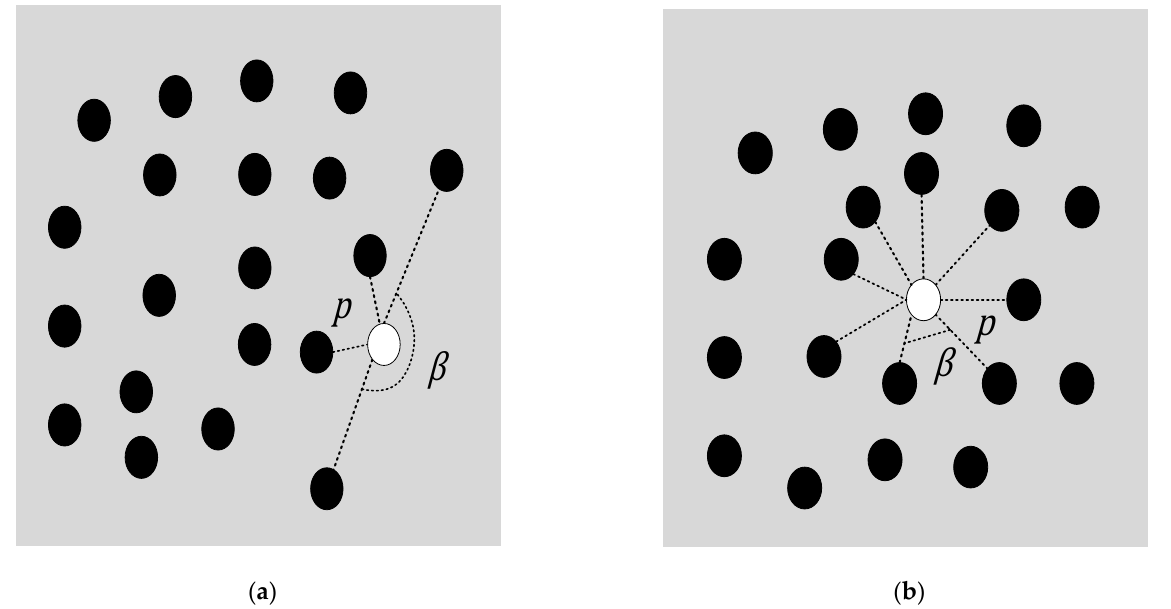
Figure 2. Boundary point extraction algorithm where ( a ) the point projected on the micro-tangent plane is on the plane’s boundary and ( b ) is inside the plane. The boundary points extraction results are shown in Figure